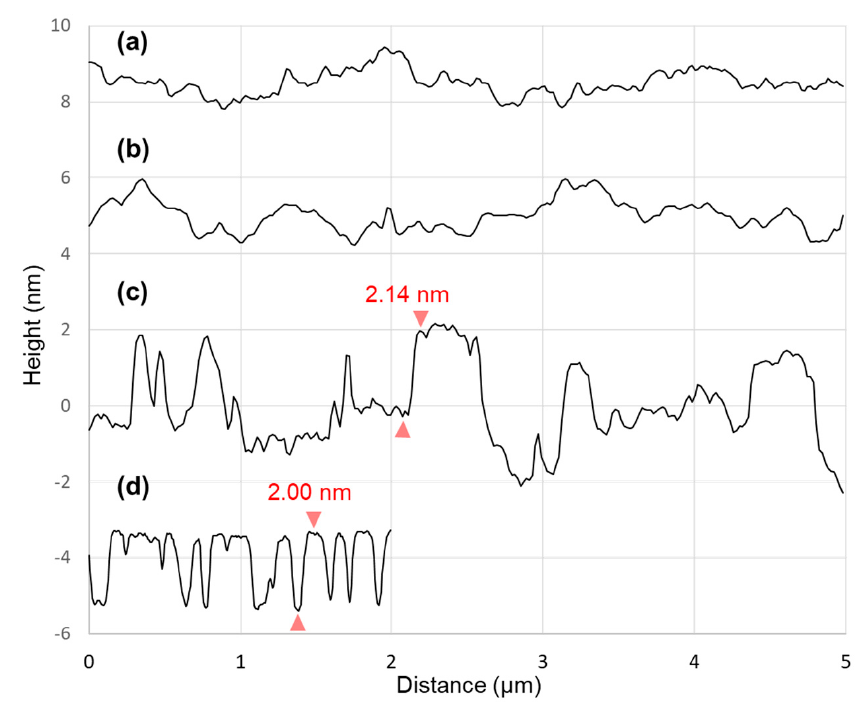
Figure 3. Profiles (with offsets for clarity) isolated from the AFM images in Figure 2 for a bare SiO 2 substrate ( a ); full-coverage OTMS SAMs prepared on a UV/ozone-treated SiO 2 substrate ( b ); islands of OTMS SAMs formed on a UV/ozone-treated SiO 2 substrate ( c ); a cleaved mica ( d ).